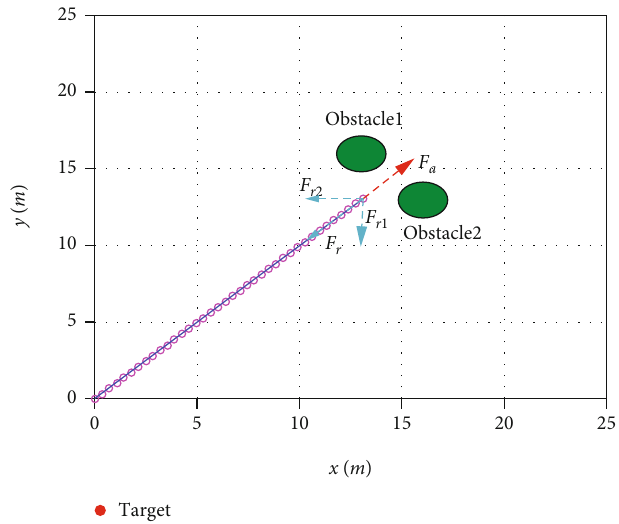
Figure 2: Scenario 1: the local minimum of TAPF with multiple